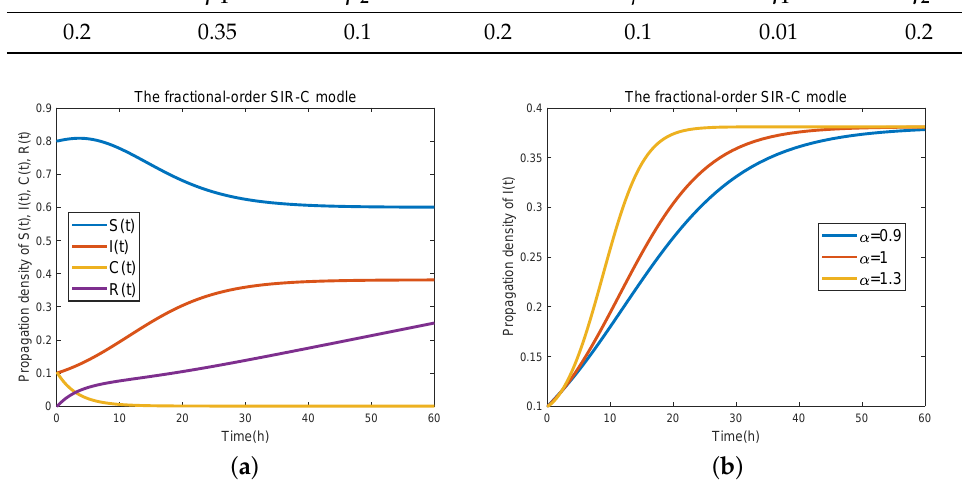
Figure 4. ( a ) Global stability of the BEP E 2 = ( 0.6,0.38,0 ) , for system (7). ( b ) Consider the effect of different differential orders of α ∈ { 0.9,1,1.3 } on the spread of cyber rumors, for system